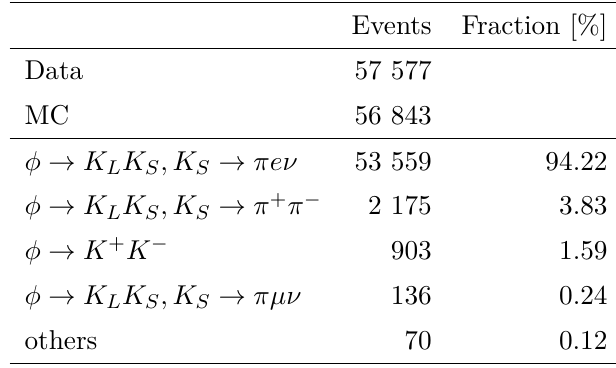
Table 2 . Number of events after the BDT and TOF selections.